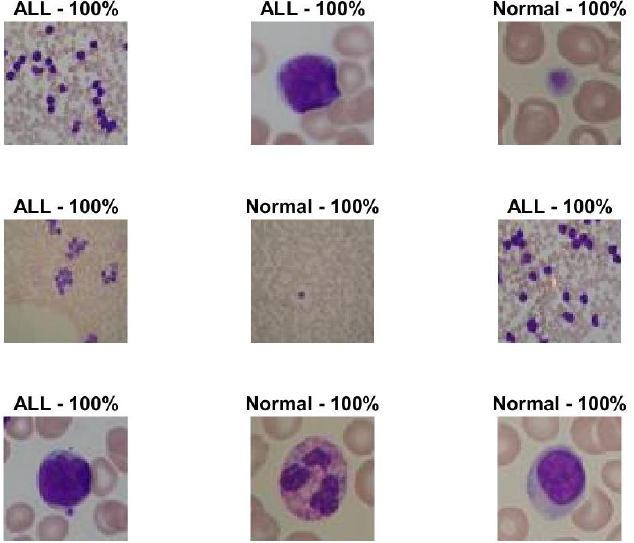
Figure 8. Sample test images along with their predicted classes and class probability. ALL denotes the diseased images.